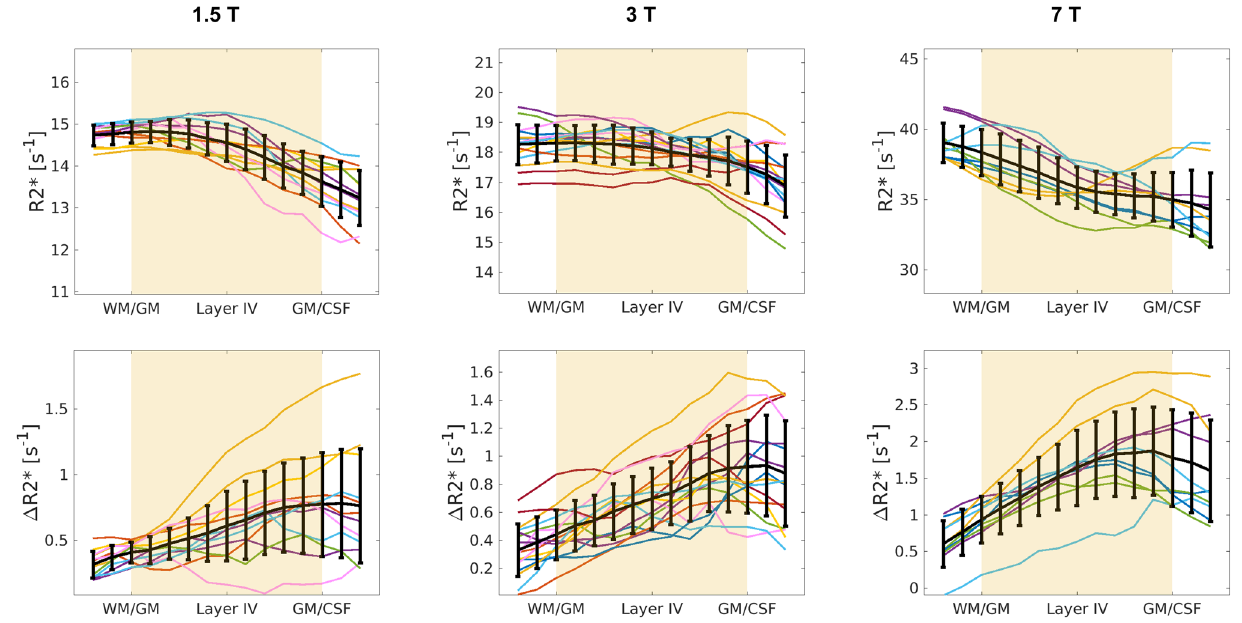
Figure 3. Individual R2* (at rest, upper row) and ∆R2* (during activation, bottom row) profiles for each subject and hemisphere (each colour corresponds to a subject and each line to the profile within a hemisphere). The black line is the mean ± std over subjects, normalized by the average T2* of grey matter at that field.